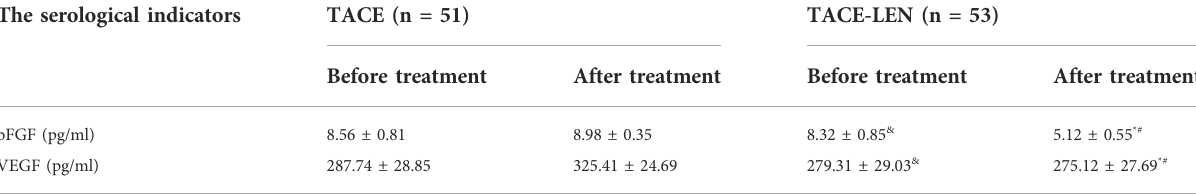
TABLE 4 Comparison of the bFGF and VEGF before and after treatment between the two groups.